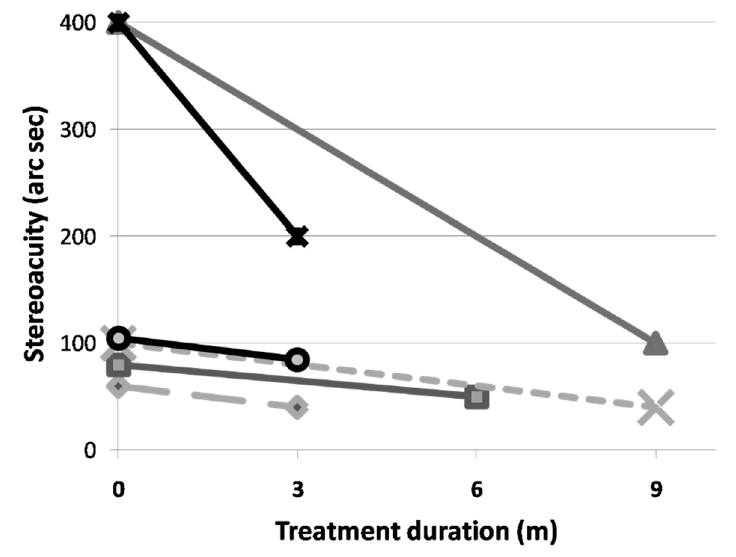
Figure 2. The individual improvement in stereoacuity after vision therapy.